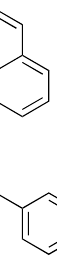
Scheme 5. The structure of ligand 6 from reference [44].